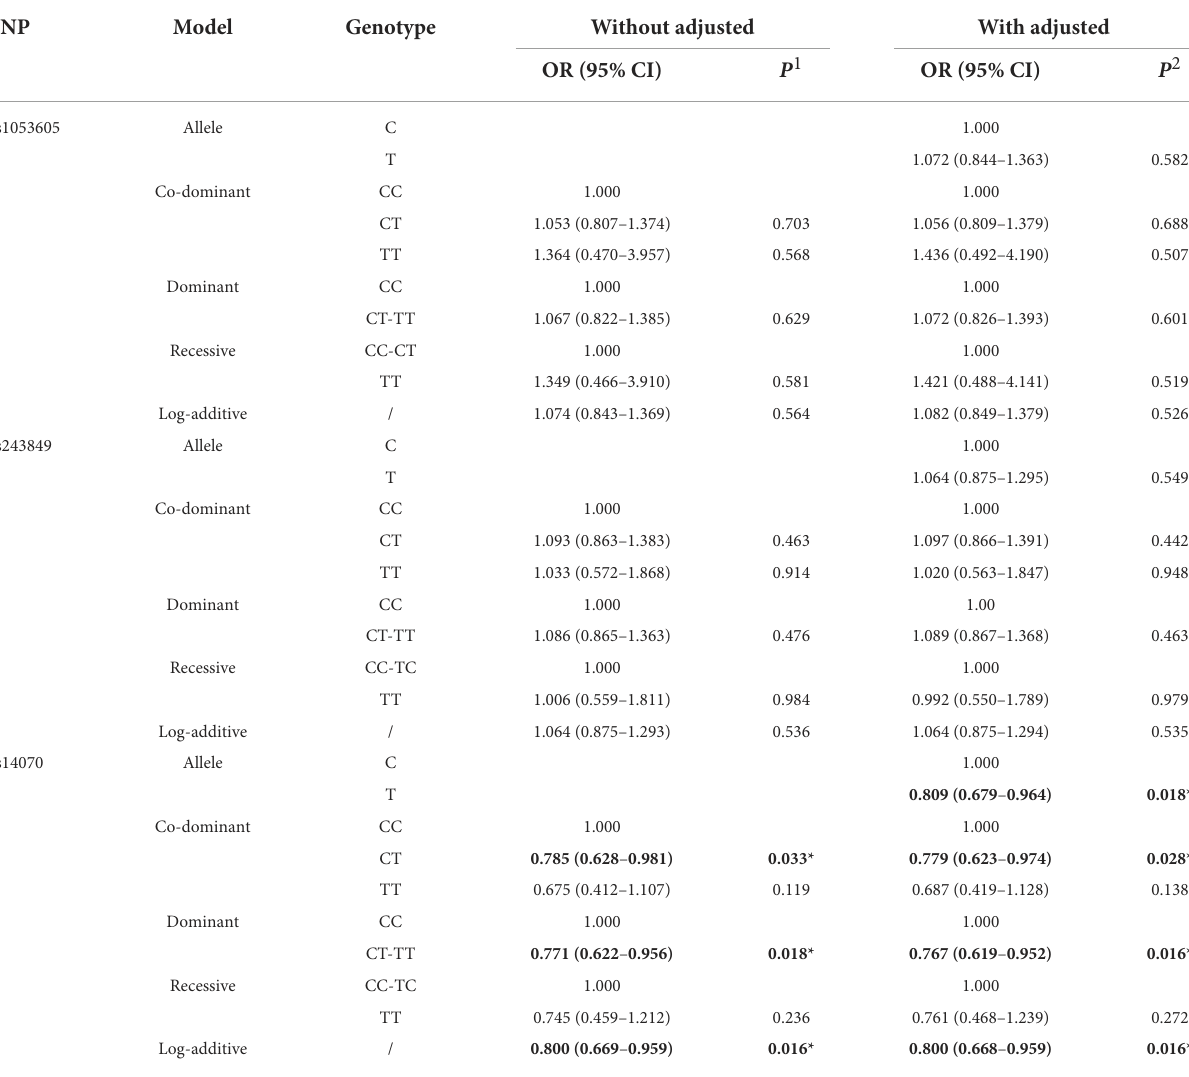
TABLE 3 Associations between SNPs of MMP2 and ischemic